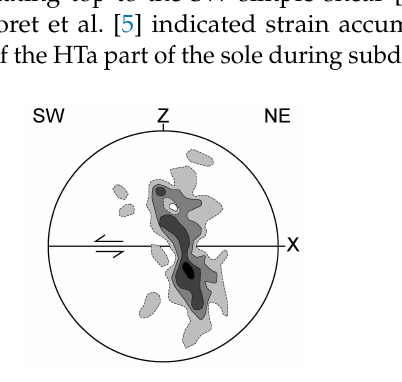
Figure 2. Quartz [c]-axis pole figure (100 grains) showing an asymmetric single girdle, interpreted as top-to-SW sense of shear, Wadi Tayin (modified after